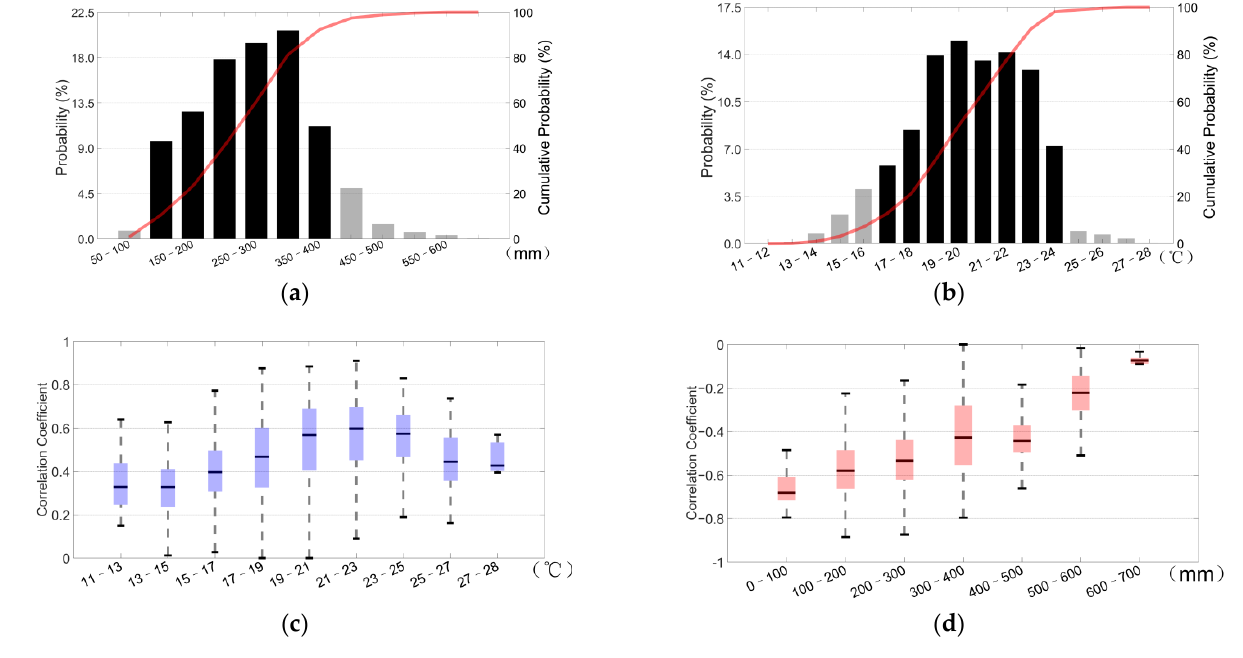
Figure 7. Statistical probability distribution of summer precipitation ( a ) and summer mean temperature ( b ) in the key climatic area (bar chart: probability, %; solid line: cumulative probability, %), boxplot of the correlation coefficient between annual NPP and summer precipitation ( c ), and box plot of the correlation coefficient between annual NPP and summer mean temperature ( d ).